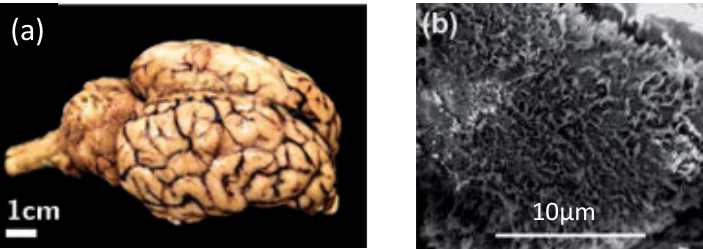
Figure 11. Examples of the non-ideal surface of soft biomaterials in the form of numerous asperities. ( a ) Macroscale: the surface of porcine brain tissue with sulci and gyri, reproduced and adapted with permission from [161]; and ( b ) microscale: the surface of human cervical epithelial cells with brush, reproduced and adapted with permission from [162].